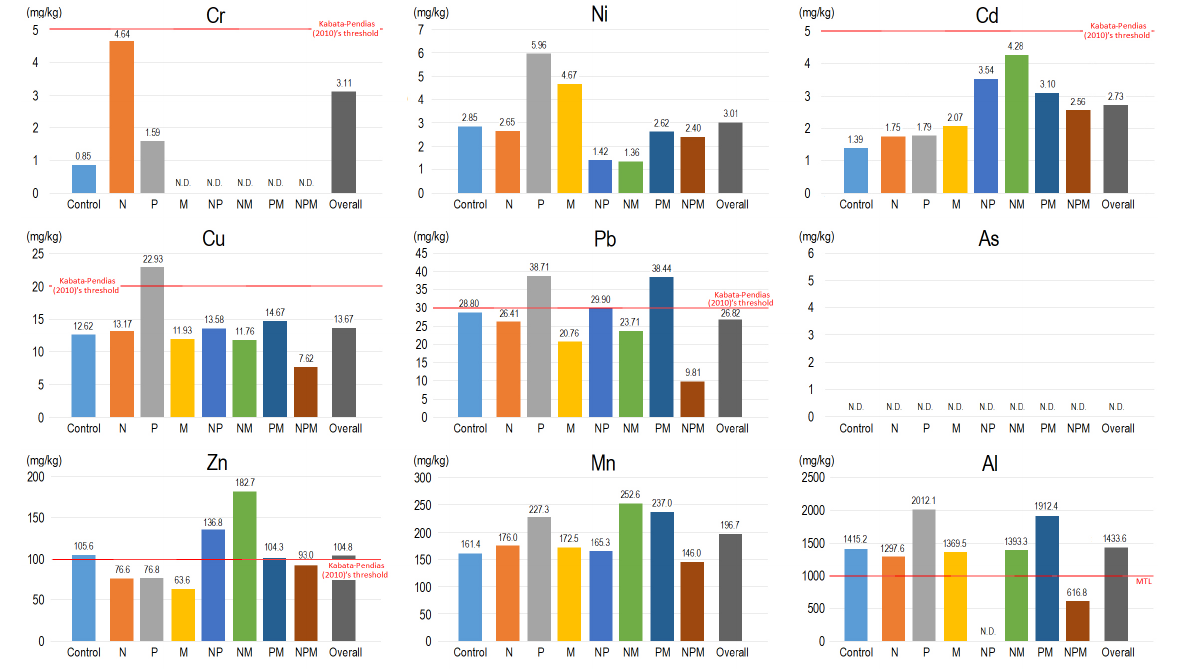
Figure 5. Metal levels of the below-ground biomass of bermudagrass under 25% sludge loading rate and different fertilization treatments in VS. (Note: N.D. = not determined due to insufficient amount of sample for